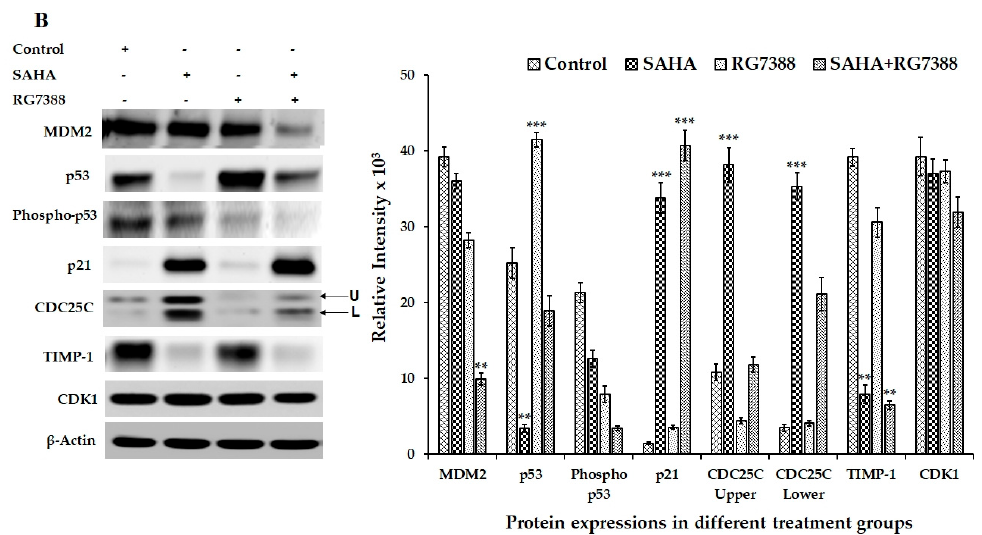
Figure 6. Representative western blot images showing the changes in the levels of cell cycle-related proteins in MCF-7 cells after SAHA, letrozole RG7388 and combination treatments. ( A ) Modulation in the levels of cell cycle-related gene proteins such as MDM2, p53, phospho-p53, p21, CDC25C, TIMP-1, and CDK1 in MCF-7 cells treated with SAHA (7.5 µ M), letrozole (100 nM) and SAHA + letrozole combination for 24 h. ( B ) Modulation of cell-cycle related protein expressions in MCF-7 cells after SAHA (7.5 µ M), RG7388 (2.0 µ M) and SAHA + RG7388 treatment for 24 h. The right panel represents the band intensity of the cell cycle proteins normalized to that of β -actin by ImageJ software. Data are presented as means ± SD from a minimum of three independent experiments. The level of significance is indicated as ** p < 0.01 and *** p < 0.001 compared to control.